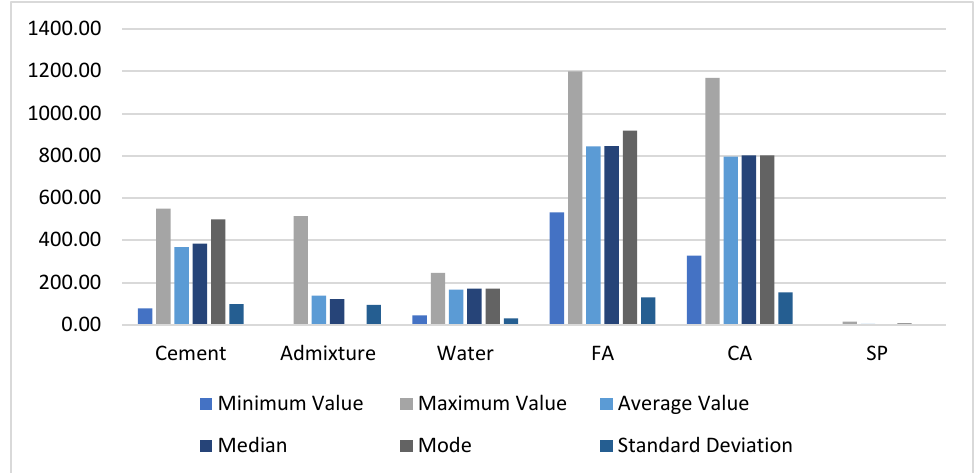
Figure 1. Statistical characteristics of input variables.